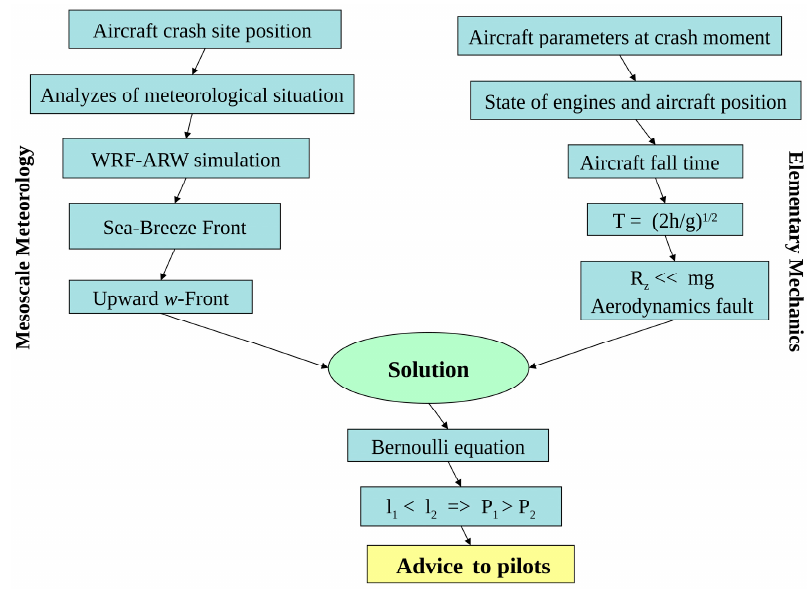
Figure 12. The scheme is using in this study to analyse the aircraft accidents.